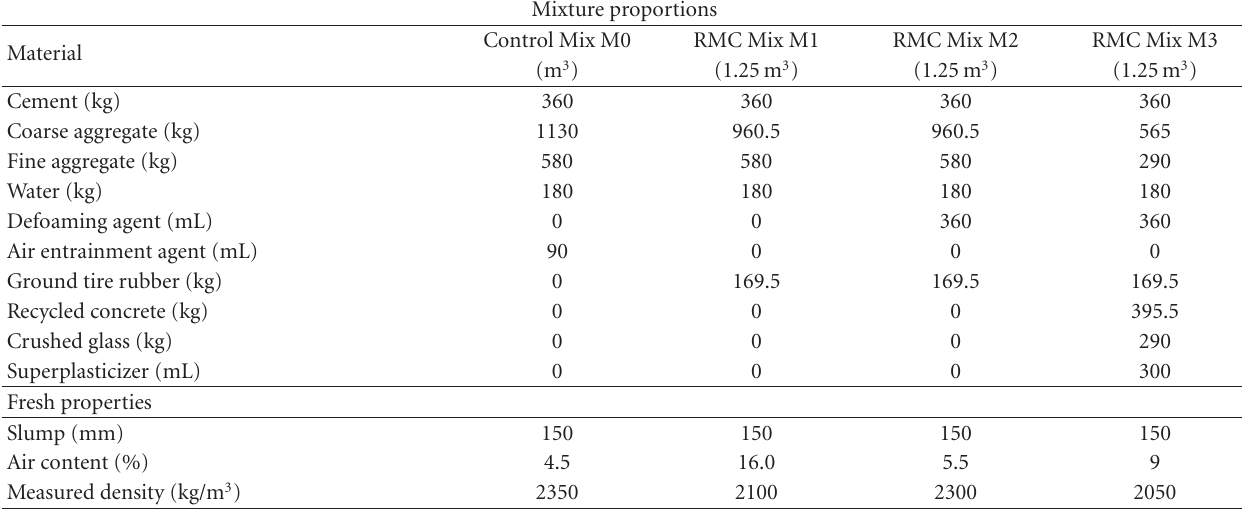
Table 1: Mix proportions and fresh